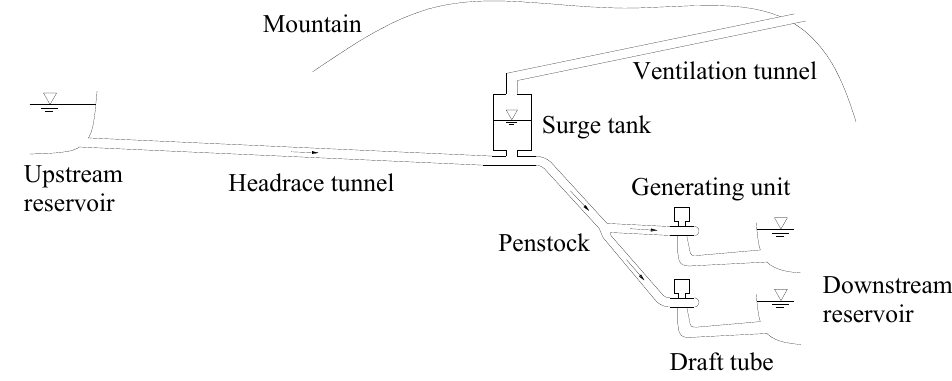
Figure 1. Schematic diagram of the layout of a surge tank and a tunnel in a HPP.